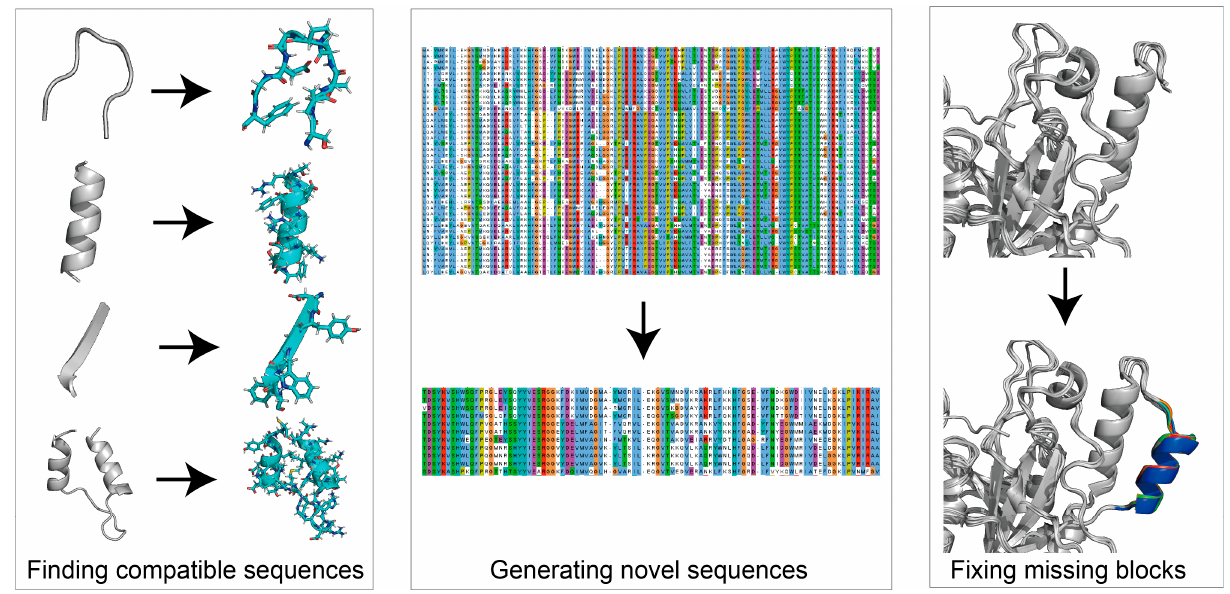
Figure 4. Utilities of protein de novo design. Protein de novo design can be used for finding compat-